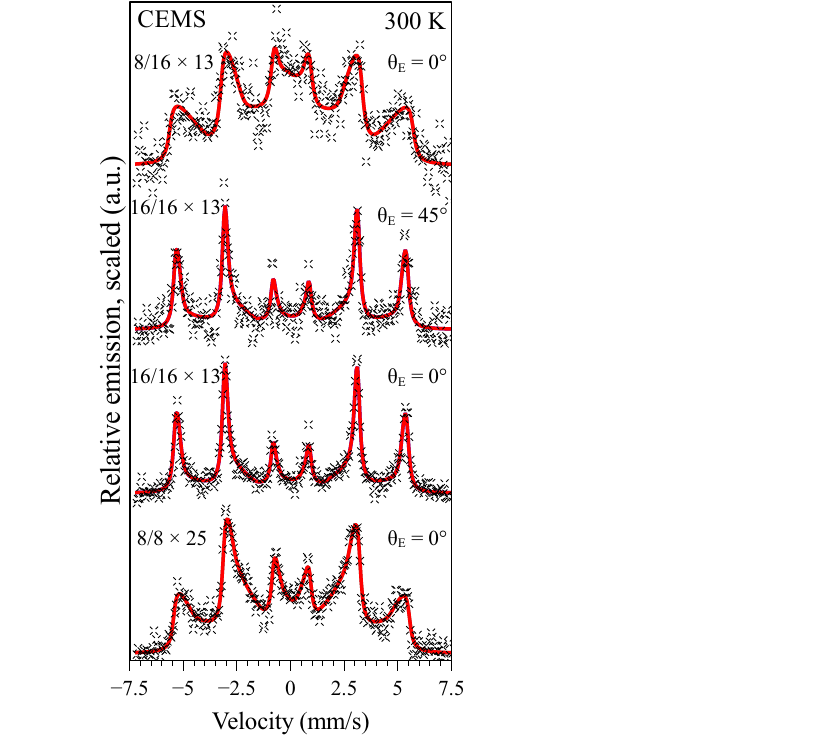
Figure 3. 57 Fe + CEMS spectra of the Fe/V superlattices at 300 K. The emission angles ( θ E ) relative to the sample surface normal are